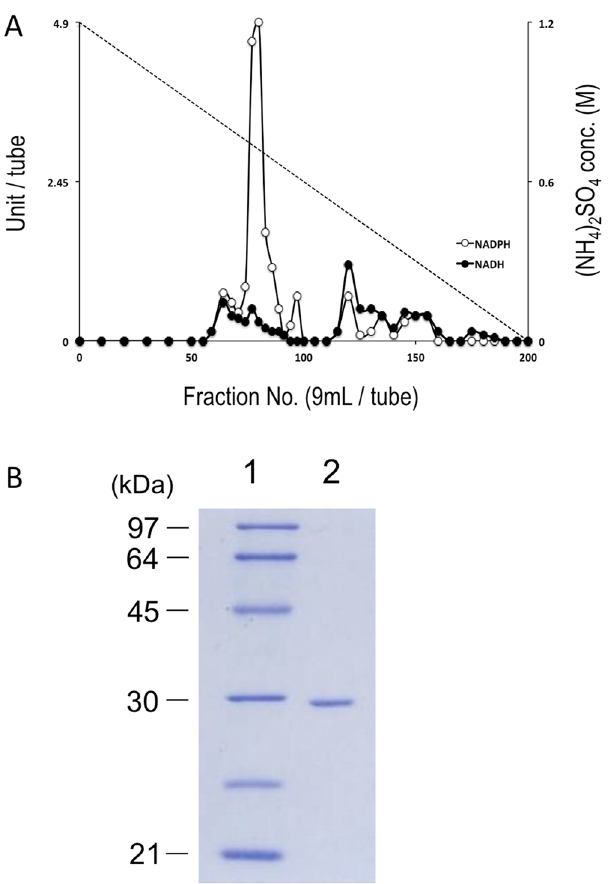
Figure 2. ( A ) Chromatographic elution profiles of B. infantis NADH and NADPH oxidases. Cell extracts, after treatment with streptomycin sulfate and ammonium sulfate, were applied to a Butyl-TOYOPEARL column equilibrated with 1.2 M ammonium sulfate in 50 mM potassium phosphate buffer (pH 7.0). After sample loading, the bound proteins were eluted with a linear gradient of ammonium sulfate, from 1.2 to 0 M, dissolved in the same buffer. Black circles, NADH oxidase activity; white circles, NADPH oxidase activity; dashed line, ammonium sulfate concentration (conc.). ( B ) SDS-PAGE of the purified B. infantis NPOX protein. After electrophoresis, the gel was stained with Coomassie brilliant blue. The protein standards (lane 1) and purified protein (lane 2) are indicated, along with the corresponding molecular masses (indicated on the left in